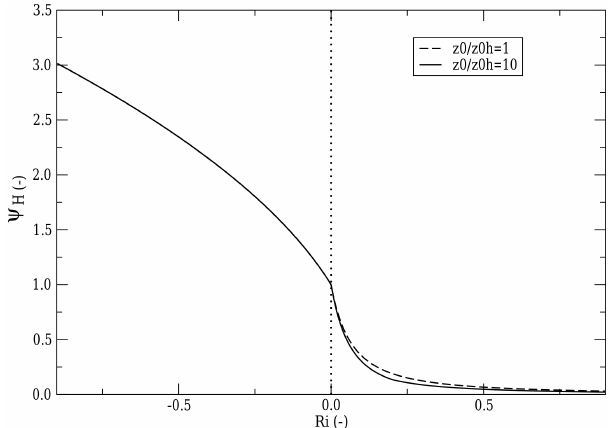
Figure 3. Stability correction term is shown using the Sellers for- mulation for R i ≤ 0 while the function for stable conditions adapted from ISBA ( R i > 0) for two ratios of z 0g /z 0gh . The ground surface roughness length is defined in Table